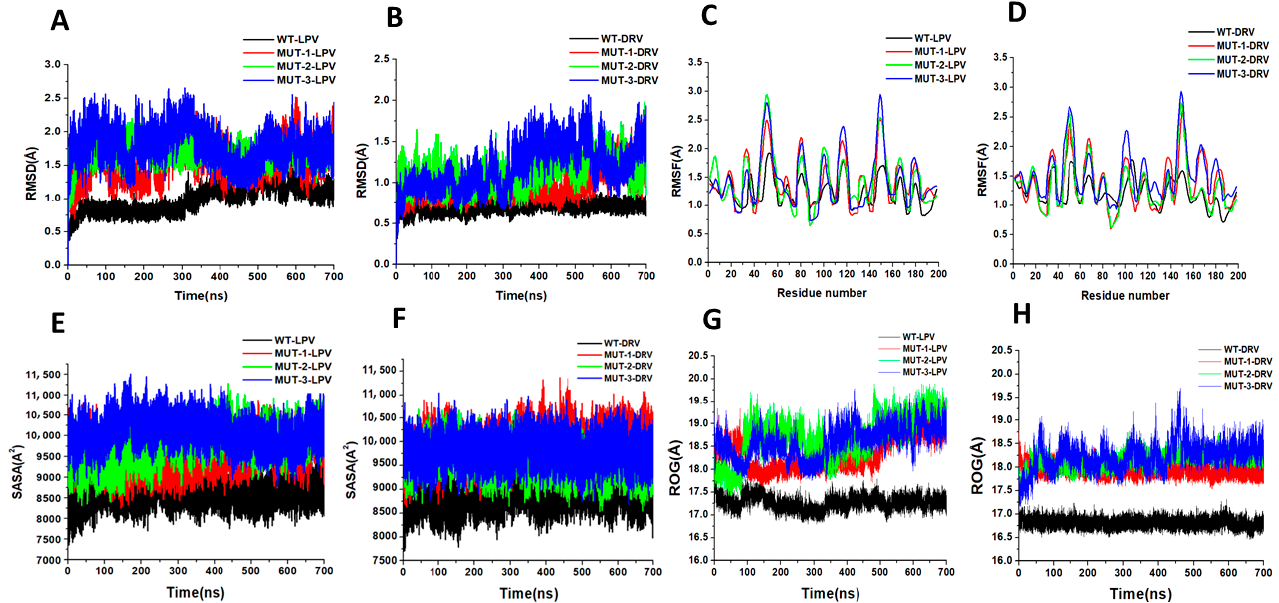
Figure 7. ( A ) Root mean square deviation (RMSD) for WT and mutant HIV ‐ 1 PR variants bound to LPV. ( B ) RMSD for WT and mutant HIV ‐ 1 PR variants bound to DRV. ( C ) RMSF Figure 1. PR variants bound to LPV. ( D ) RMSF for WT and mutant HIV ‐ 1 PR variants bound to DRV. ( E ) Solvent ‐ accessible surface area (SASA) for WT and mutant HIV ‐ 1 PR variants bound to LPV. ( F ) SASA for WT and mutant HIV ‐ 1 PR variants bound to DRV. ( G ) Radius of gyration (ROG) for WT and mutant HIV ‐ 1 PR variants bound to LPV. ( H ) ROG for WT and mutant HIV ‐ 1 PR variants bound to DRV.